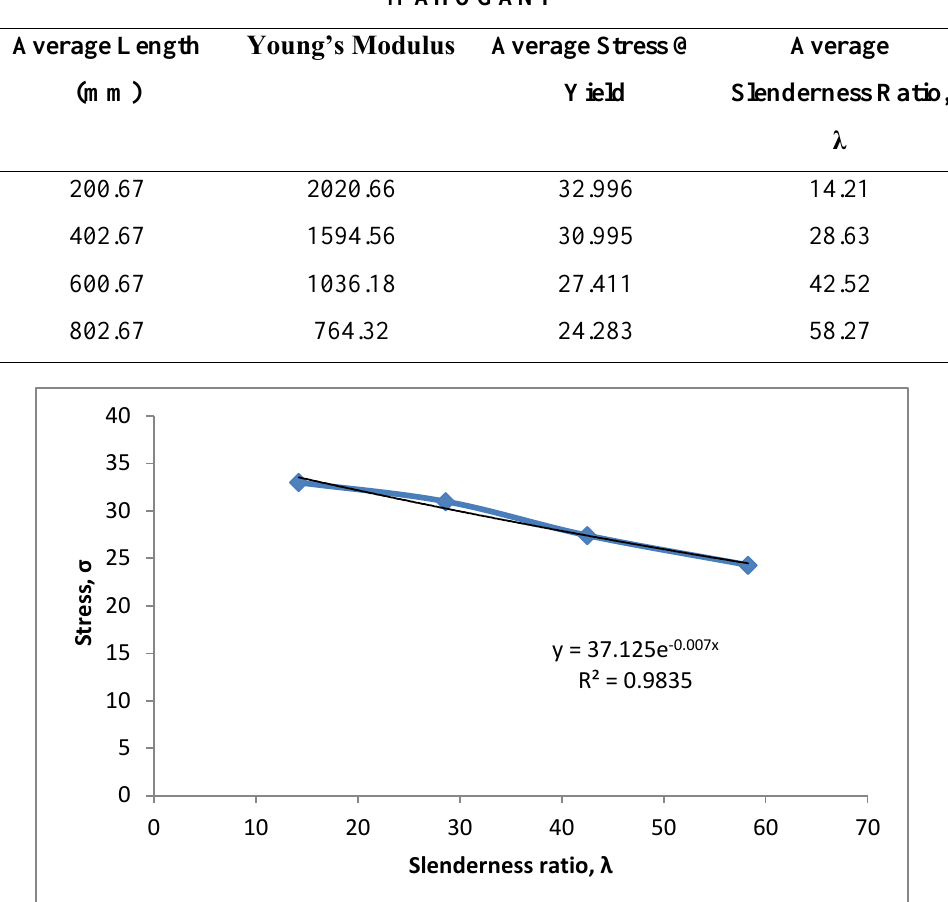
Fig. 6. Average Stress @ Yield vs. Slenderness Ratio Curve for